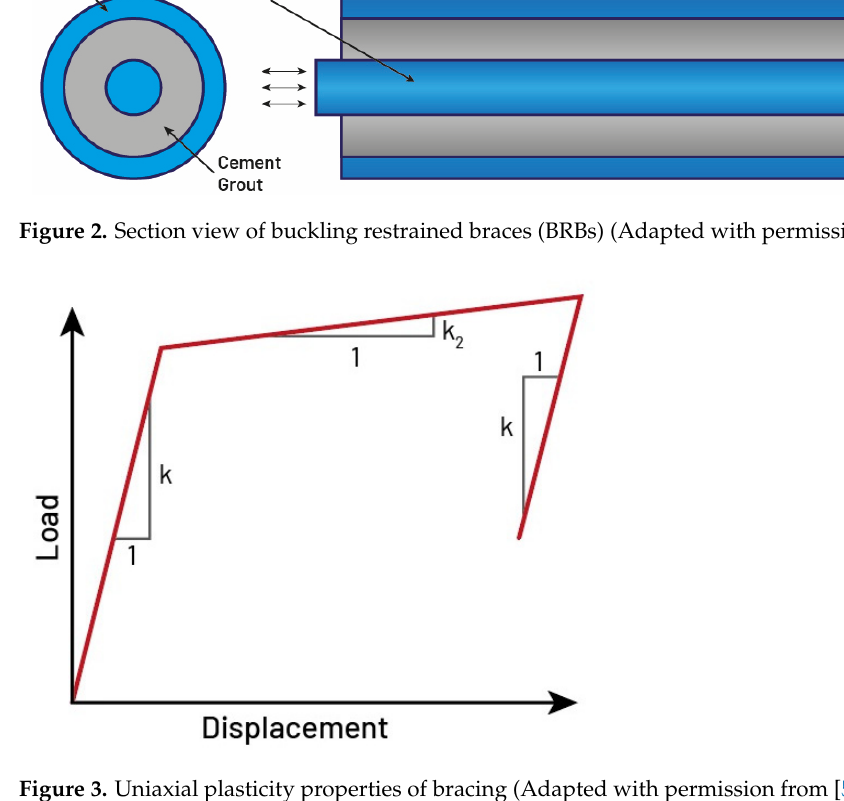
Figure 3. Uniaxial plasticity properties of bracing (Adapted with permission from [5]).